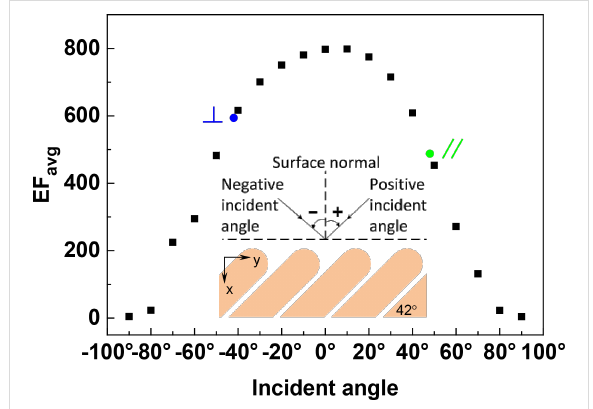
Figure 8: The angular dependent EF avg of S42 AgNR 2D hexagonal array with AR = 3.5. The excitation wavelength is 632.8 nm. The insert illustrates the incident direction and angle. The incident polarization is in the x – y plane and perpendicular to the propagation. The symbols, and //, denote that the incident directions are perpendicular and parallel to the long axis of the nanorods,